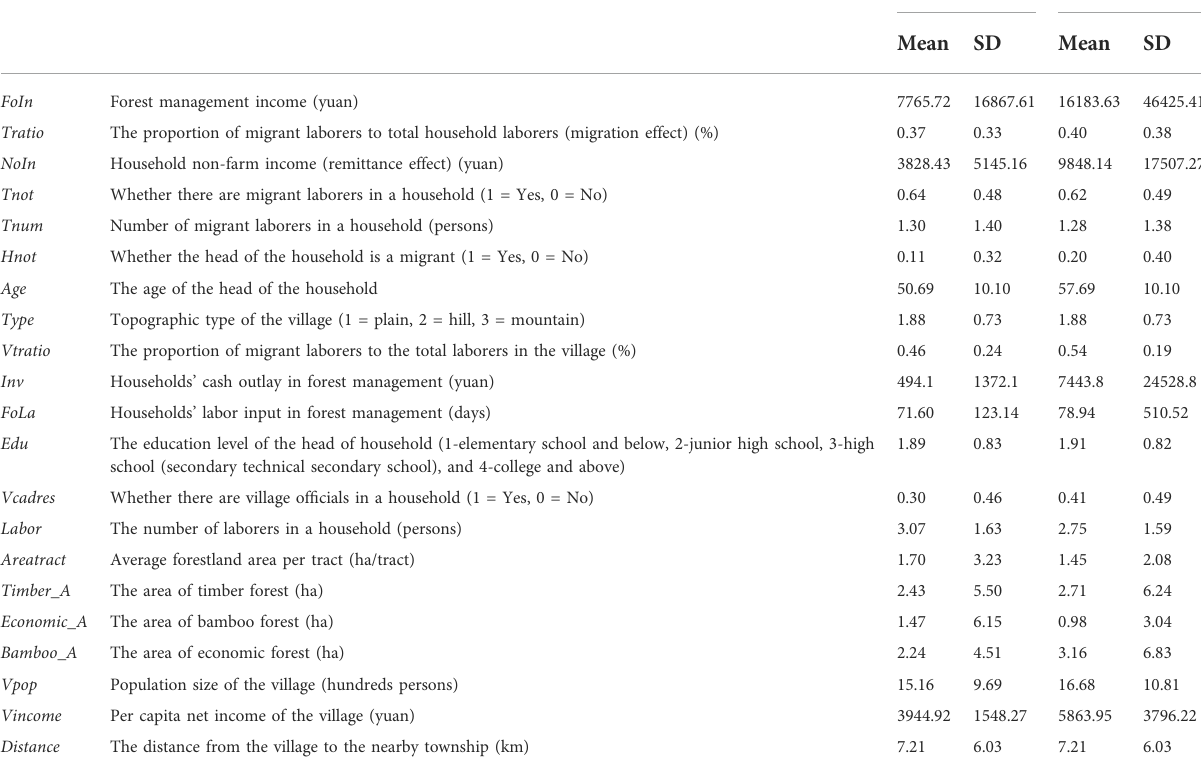
TABLE 1 Descriptive statistics of the survey